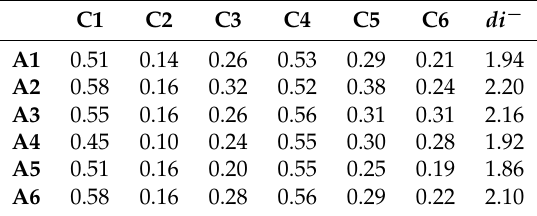
Table 12. Distance of FNIS.